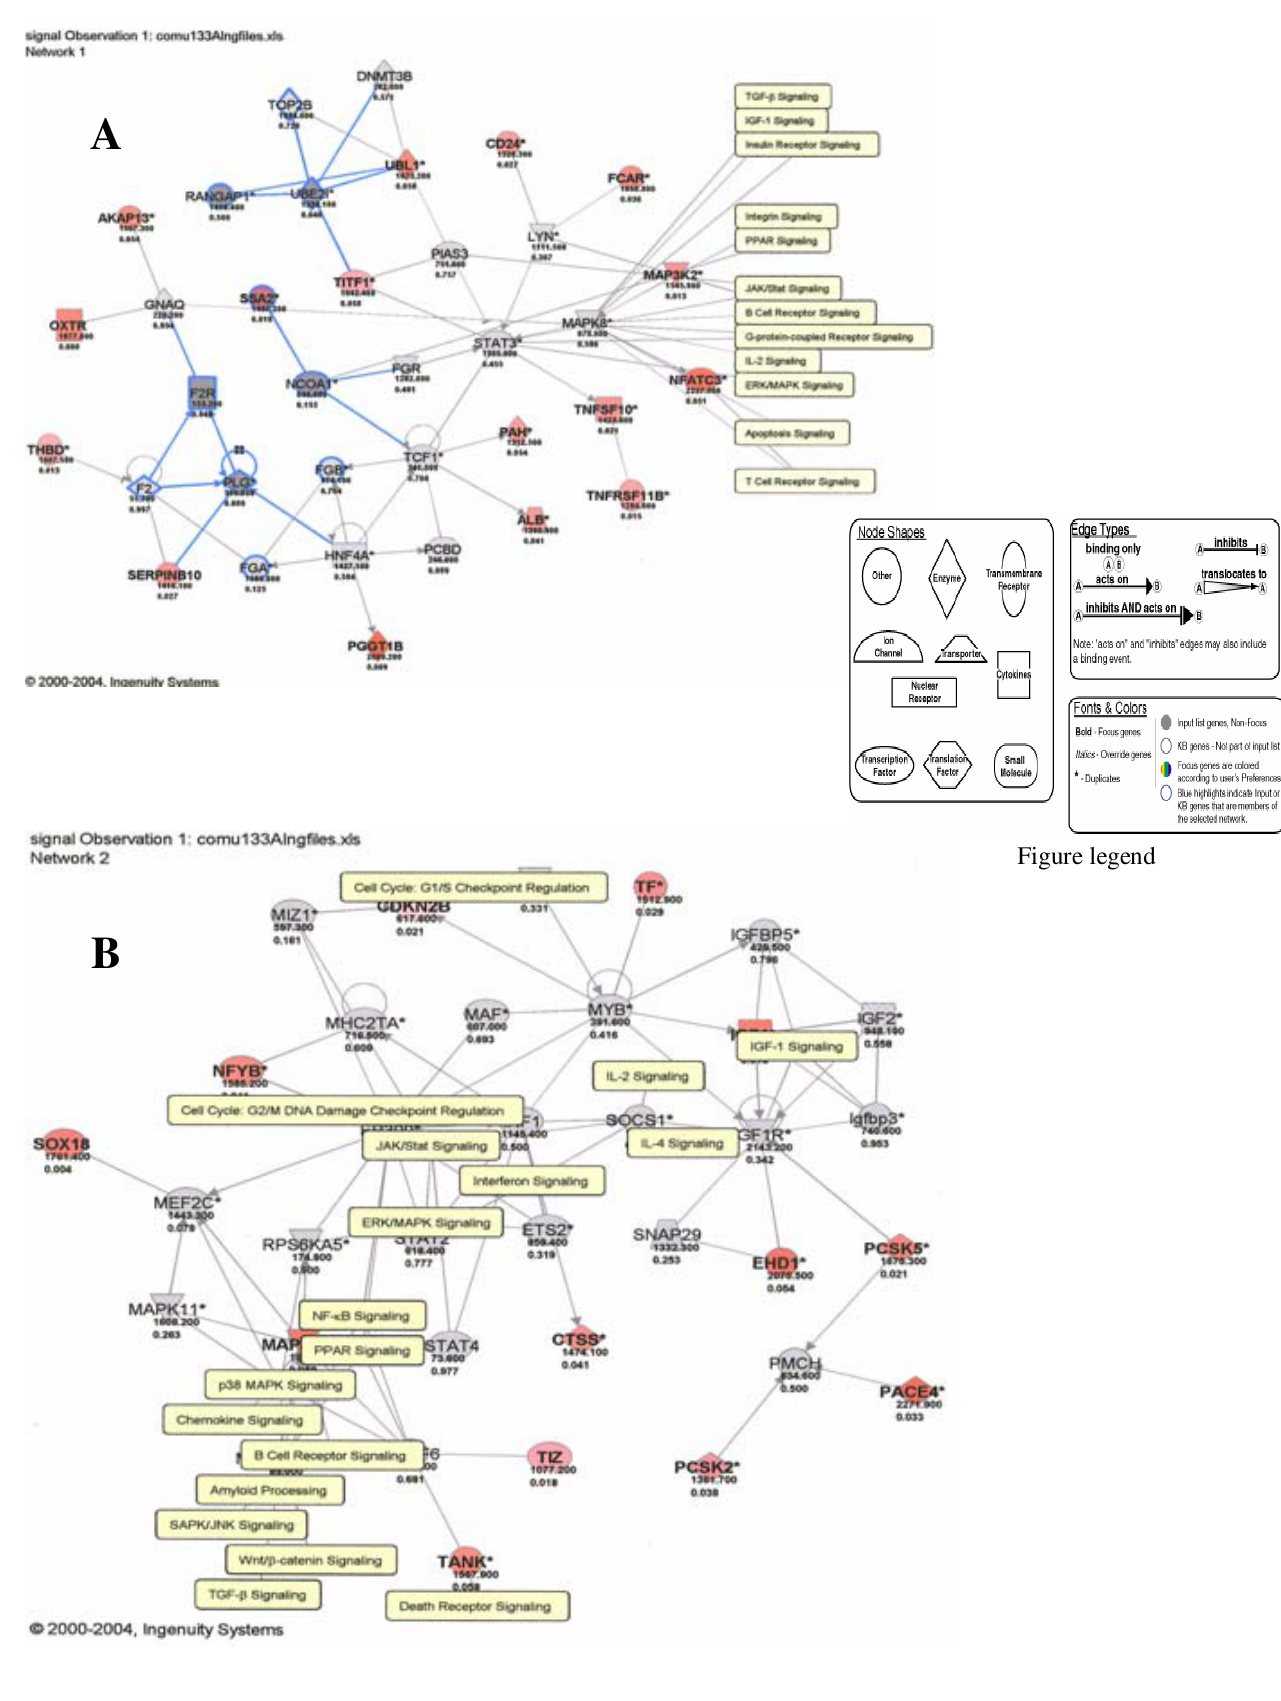
cells (A: Network 1; B: Network 2